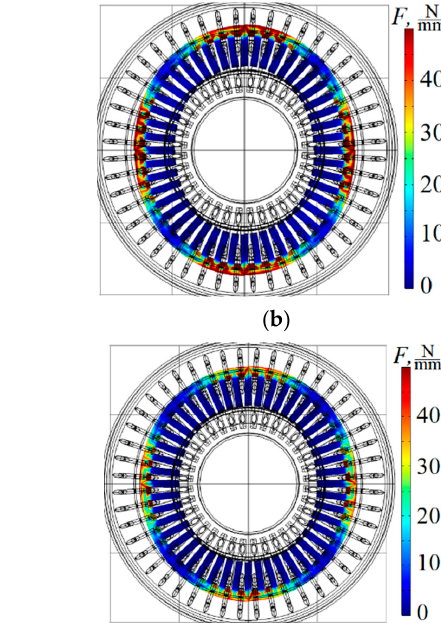
ance: ( a ) I A = I B = I C ; ( b ) I A = 1.1 ·I B = 0.9 ·I C ; ( c ) I A = 1.4 ·I B = 0.8 ·I C ; ( d ) I g 3 = 15.4 A, I g 5 = 7.7 A , I A = 1.4 ·I B =